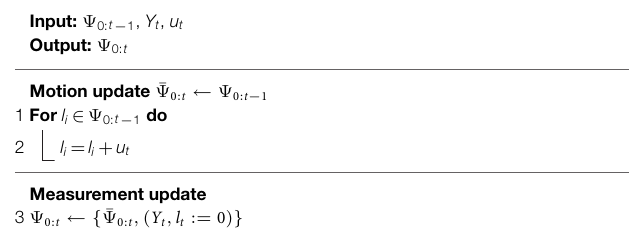
ALGORITHM 1 | Memory likelihood